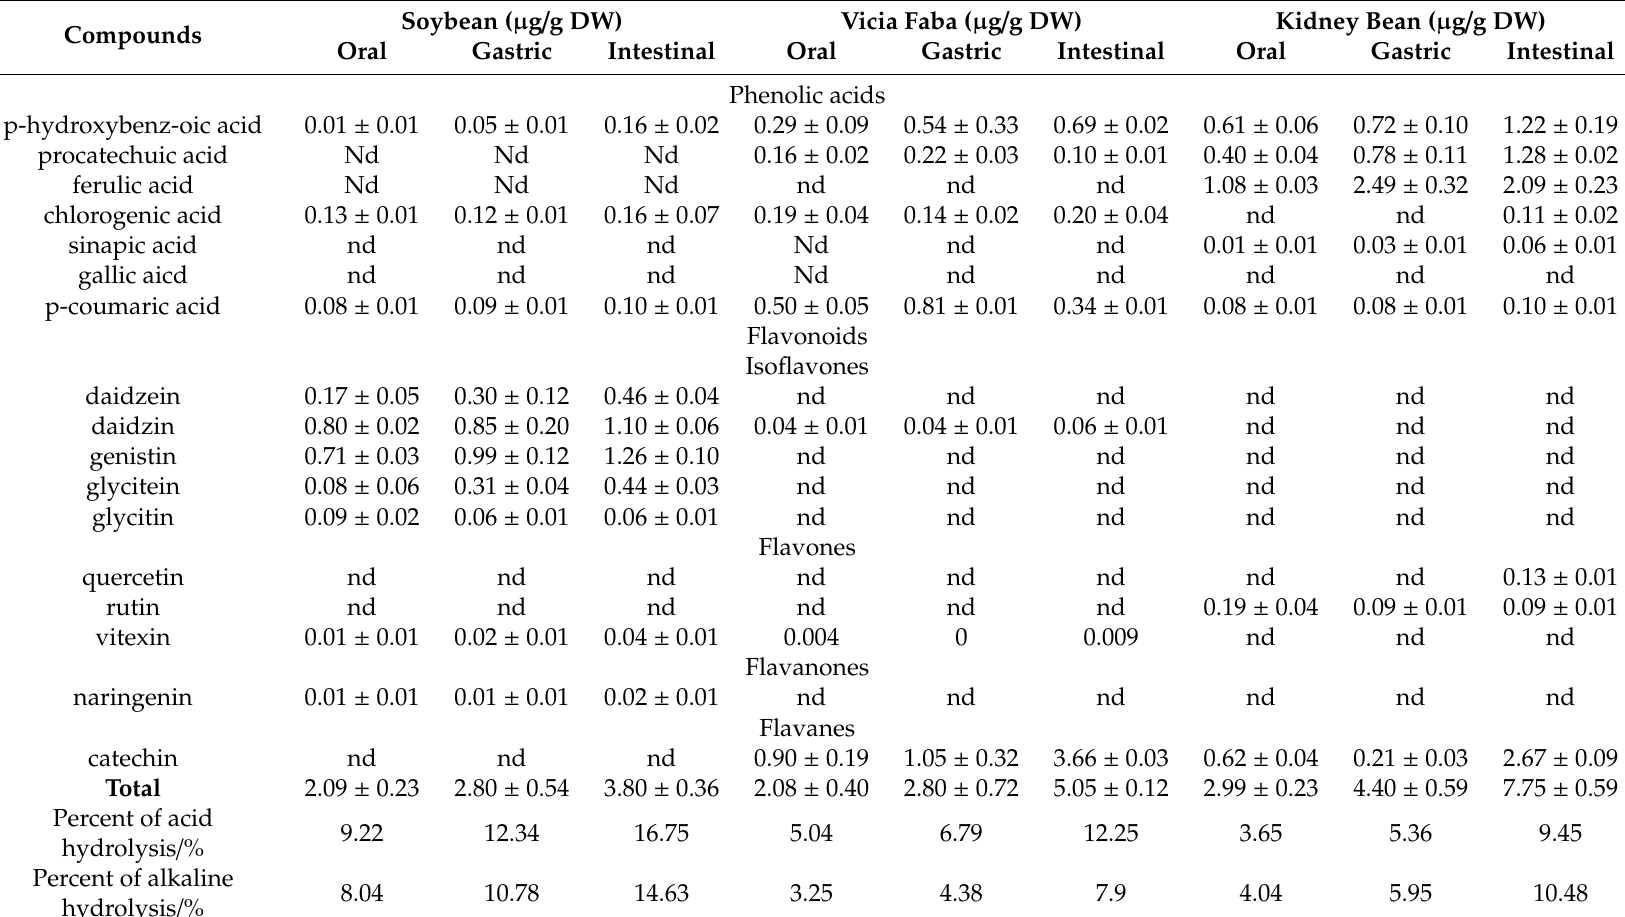
Table 4. Quantitative results of the phenolics after digestion by HPLC-ESI-QqQ-MS